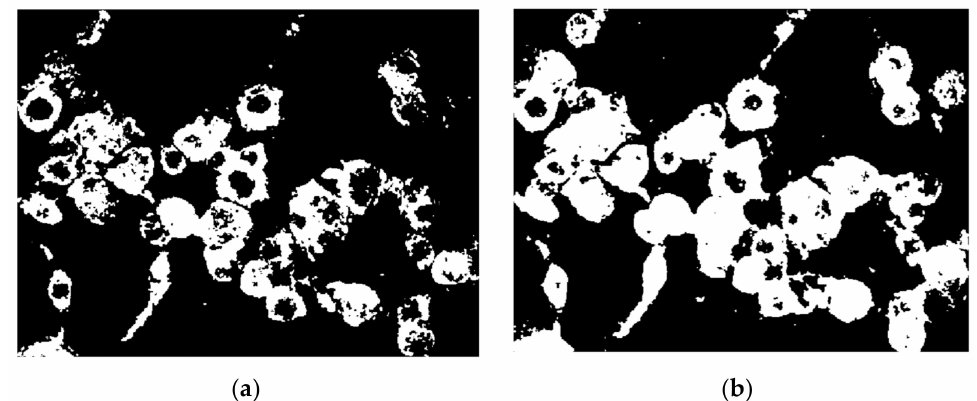
Figure 9. Binary conversion using ( a ) global threshold, and ( b ) Otsu threshold.